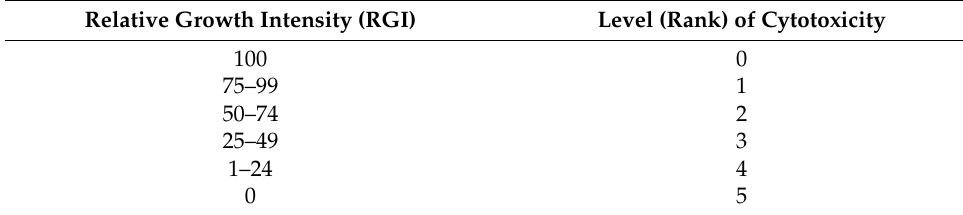
Table 1. Cytotoxicity assessment